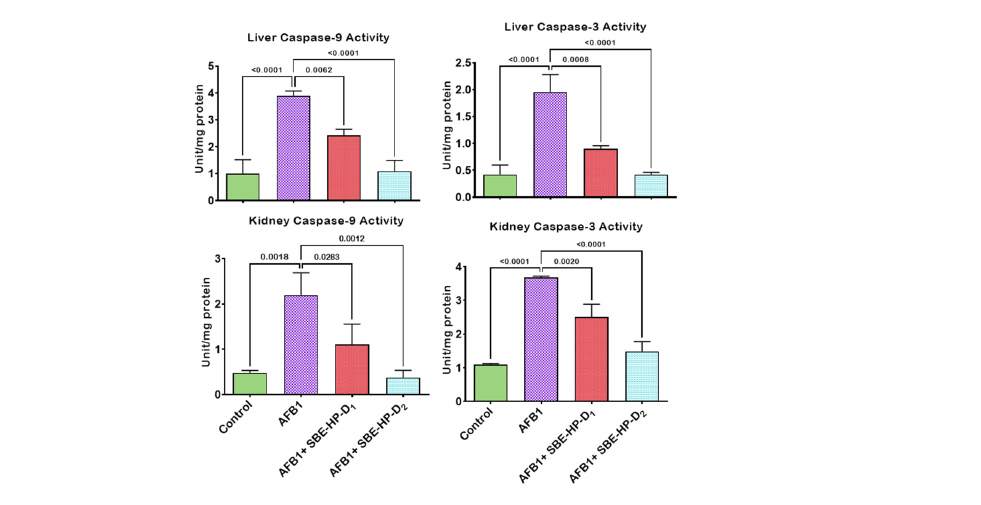
Figure 10. E ff ect of SBE-HP on tissue concentrations of caspase-9 and caspase-3 in the liver and kidney of rats treated with AFB 1 for 28 d. AFB 1 at 50 µg/kg; SBE-HP-D1 at 5 mg/kg; SBE-HP-D2 at 10 mg/kg. Values are expressed as mean ± SD for six rats per treatment cohort. Connecting lines indicate groups compared to one another. The signi fi cance level was set at (p < 0.05 ) ; p < 0.05 suggests the level of signi fi cance; p > 0.05: not signi fi cant. AFB 1 : A fl atoxin B1; D1: lower dose; D2: higher dose.